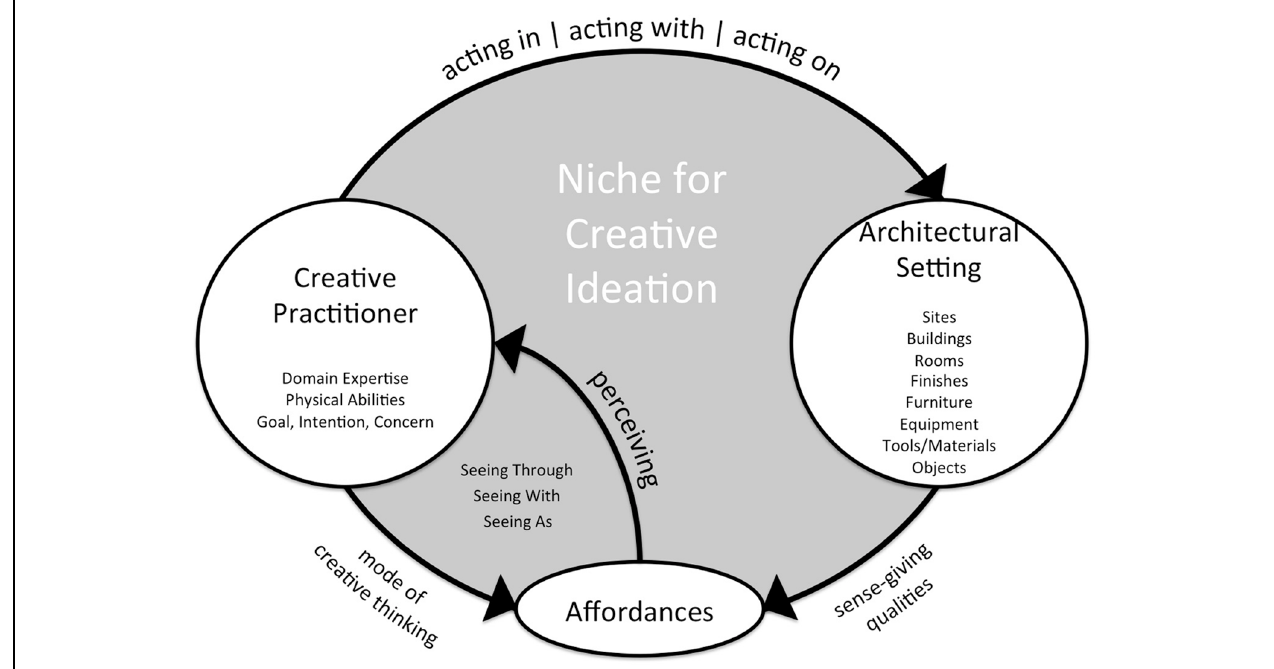
FIGURE 4 | Framework for an ecological model of